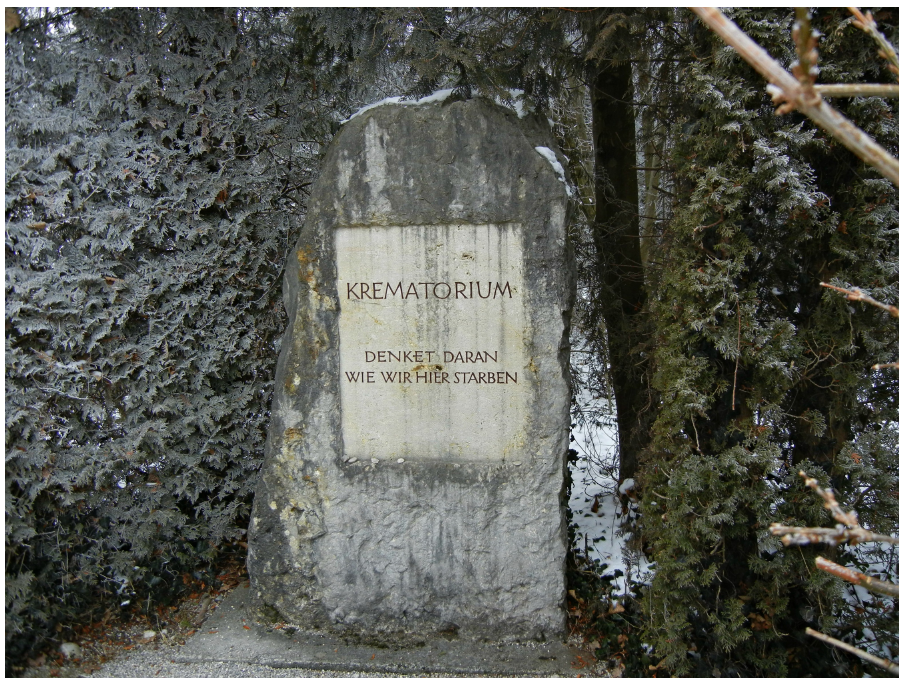
Figure 2: Crematorium entrance at Dachau. Photo by Paul R. Abramson,